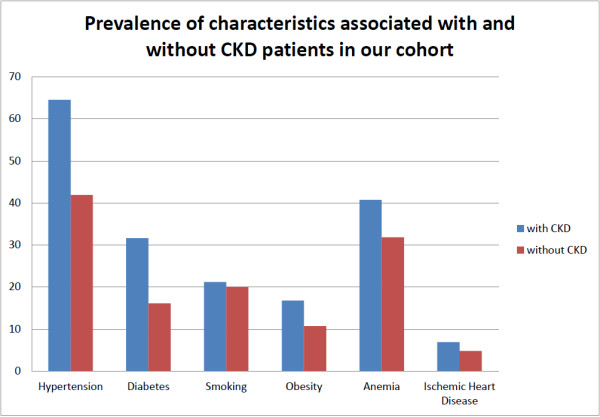
Prevalence of characteristics associated with and without CKD patients in our cohort.